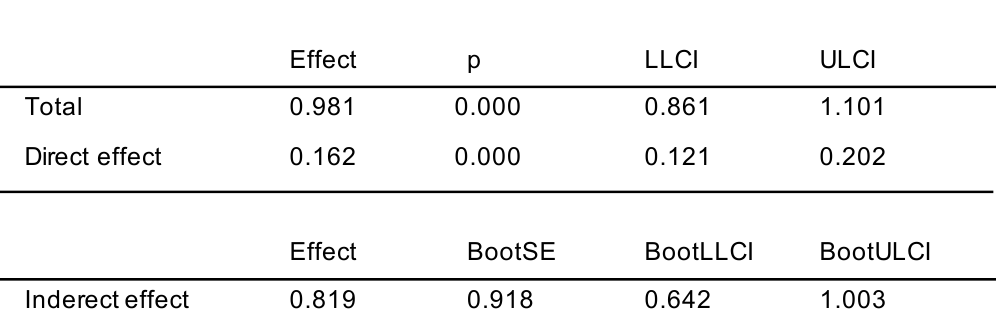
Table 2: Direct & Inderect